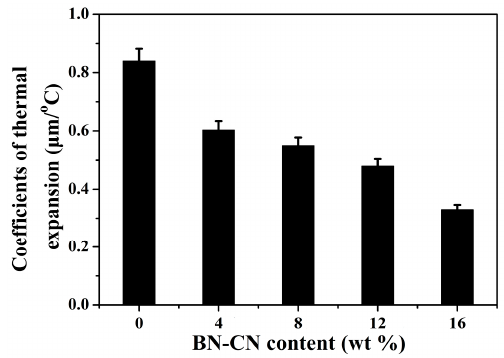
Figure 9. Coefficients of thermal expansion value of the PEN-g-BN hybrids. Figure 9. Coe ffi cients of thermal expansion value of the PEN-g-BN